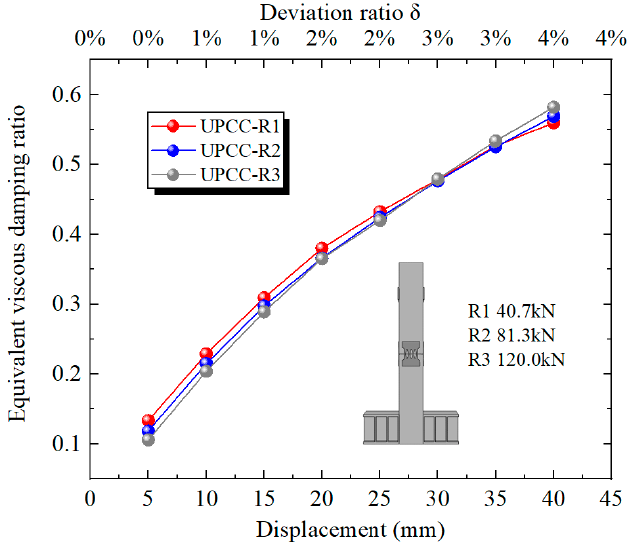
Figure 20. Equivalent viscous damping ratio under different initial prestress.